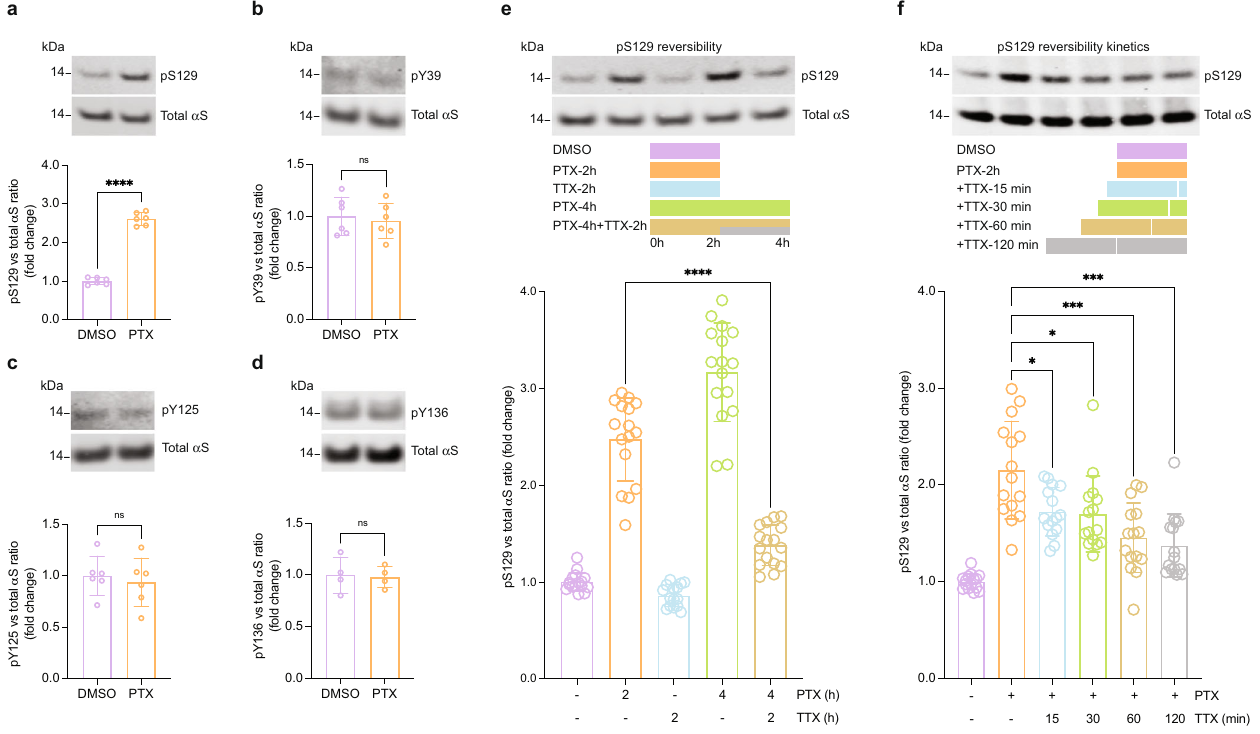
Fig. 2 Activity-dependent α S phosphorylation is S129-speci fi c and reversible. a – d DIV17-21 rat cortical neurons treated with 20 µM PTX for 2 h. WB for total α S and indicated phospho-sites. N = 6 ( a – c ) or 4 ( d ) independent experiments on different days. **** p < 0.0001; ns not signi fi cant. Mean + / − SD. Paired t -tests; two-tailed. e Reversible pS129 triggered by neuronal activity in DIV17-21 rat cortical neurons as indicated in the schematic (20 µM PTX, 1 µM TTX). WB for total α S and pS129. N = 4 independent experiments on different days, n = 16 biological replicates total; **** p < 0.0001. Mean + / − SD. Brown-Forsythe and Welch ANOVA with Dunnett ’ s T3 post hoc test for multiple comparisons. f Kinetics of reversible pS129 in DIV17-21 rat cortical neurons as indicated in the schematic (20 µM PTX, 1 µM TTX). WB for total α S and pS129. N = 5 independent experiments on different days, n = 15 biological replicates total; * p < 0.1; *** p < 0.001. Mean + / − SD. Brown- Forsythe and Welch ANOVA with Dunnett ’ s T3 post hoc test for multiple